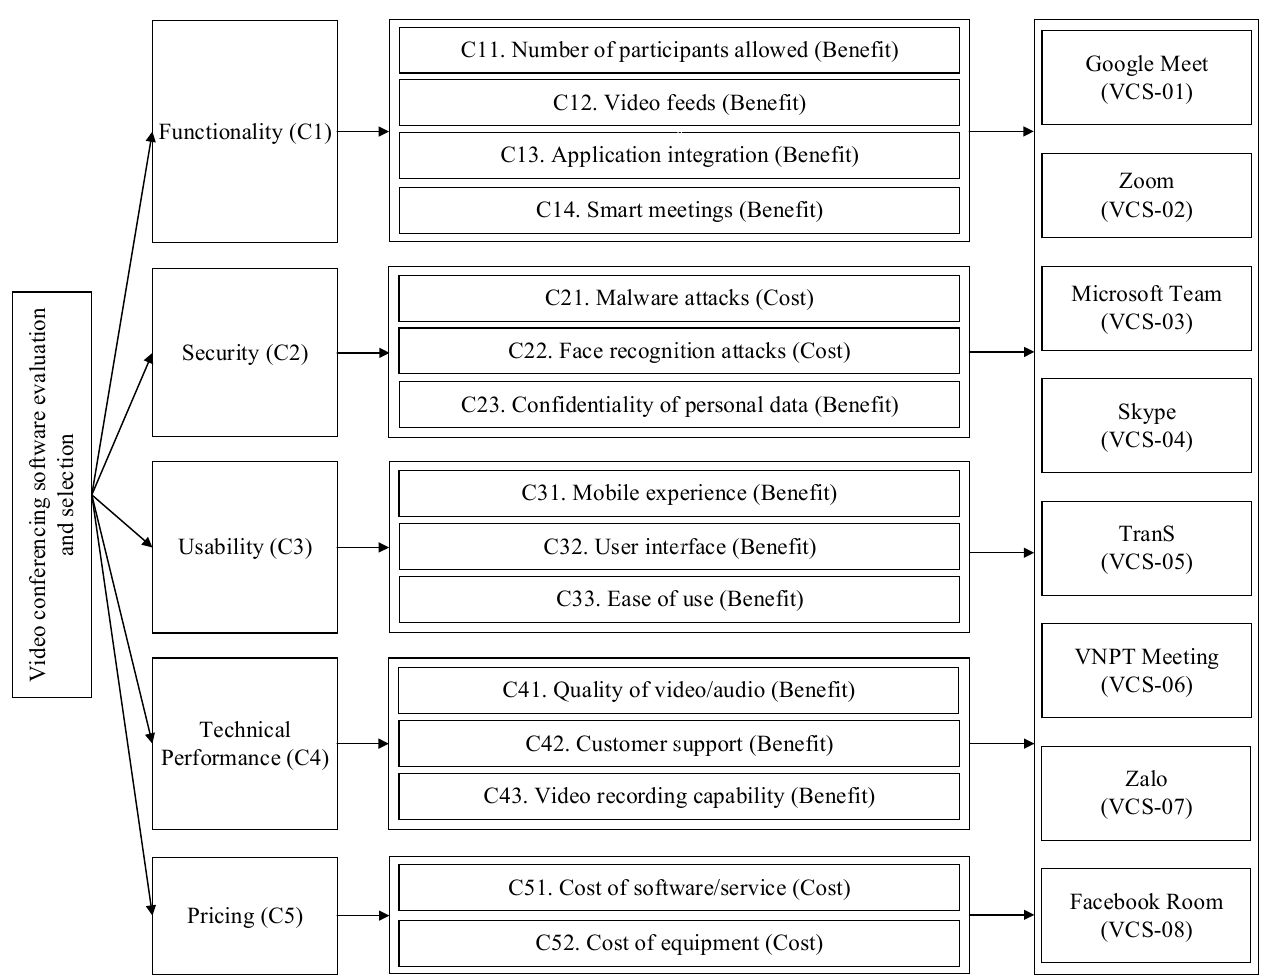
Figure 3. The hierarchical tree for evaluation of video conferencing software. The grey number is transformed to a crisp number to check the consistency ratio ( CR )